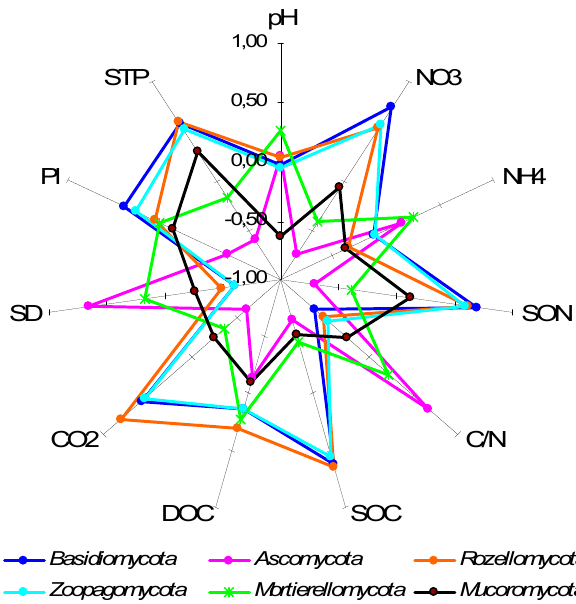
Figure 5. Correlation coefficients (Spearman’s) between soil properties and relative abundance of some fungal phyla. The coefficients exceeding │ 0.51 │ are statistically significant at p ≤ 0.05 level.